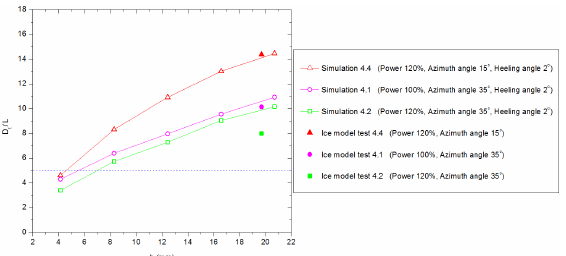
Figure 21: Comparison between the simulated turning circle diameters and the estimated values from the model tests. The turning circle di- ameter D t is divided by ship length L . All numbers are at model